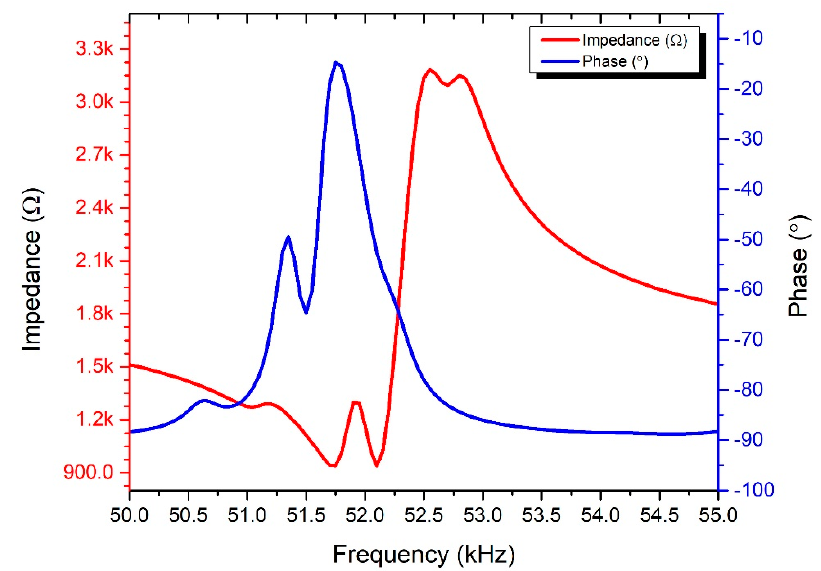
Figure 8. Measured impedance–frequency and phase–frequency characteristics.